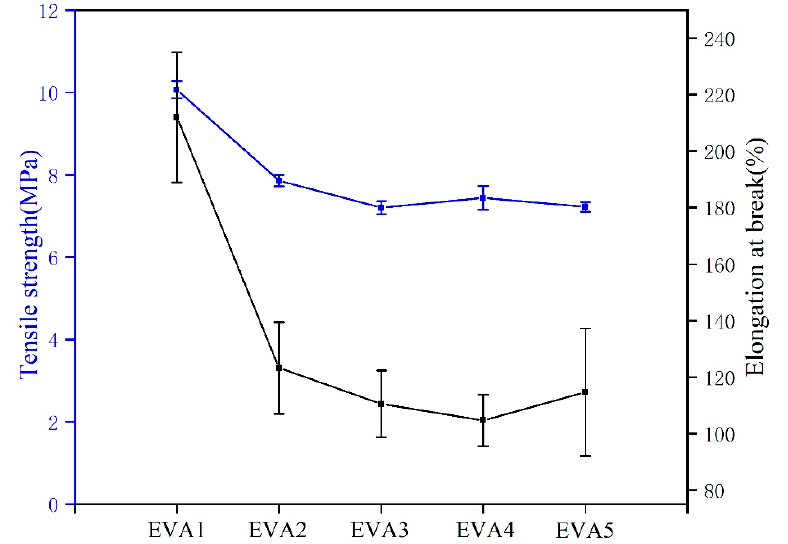
Figure 14. The mechanical properties of EVA/MH